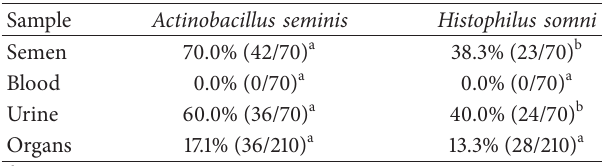
Table 1: Frequency (%) of Actinobacillus seminis and Histophi- lus somni isolation from semen, blood, urine, and tissue samples from experimentally infected rams during six weeks of